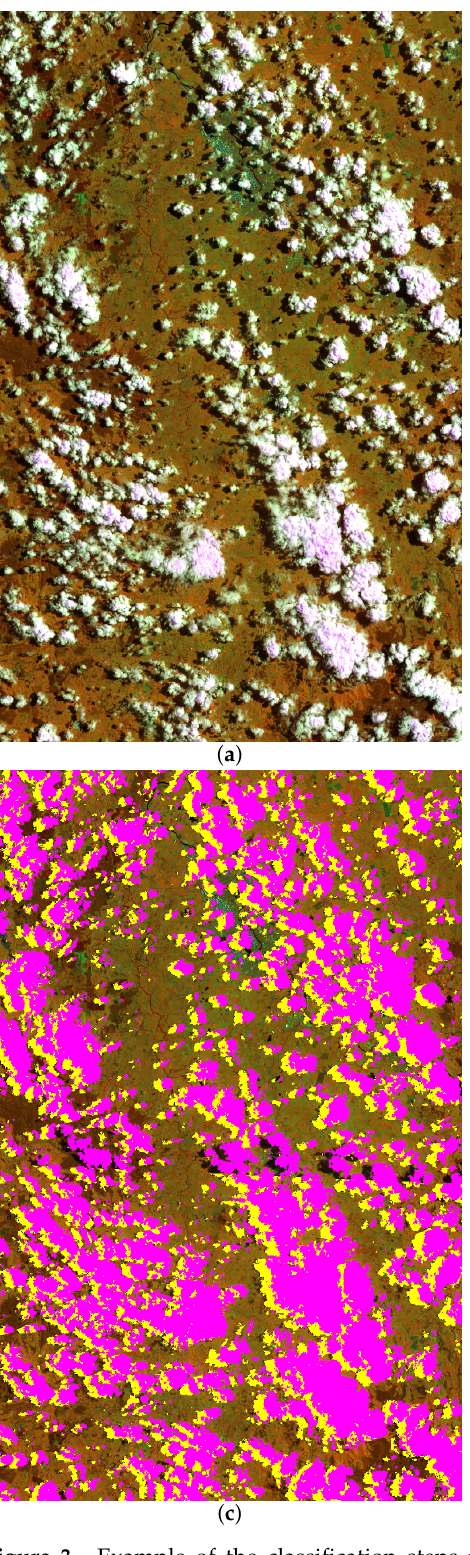
Figure 3. Example of the classification steps in the cloud-masking workflow. Panel ( a ) is the original image, ( b ) is the result of the parallax cloud detection (classification accuracy of cloud and cloud-shadow 75%), ( c ) is the result of using Fmask with parallax input to classify shadow (single-date result, classification accuracy of cloud and cloud-shadow 91%), and ( d ) is the Tmask result using temporal processing informed by the full record of single-date results (classification accuracy of cloud and cloud-shadow 98%). Panels ( c , d ) use the results of image segmentation to ensure whole objects are